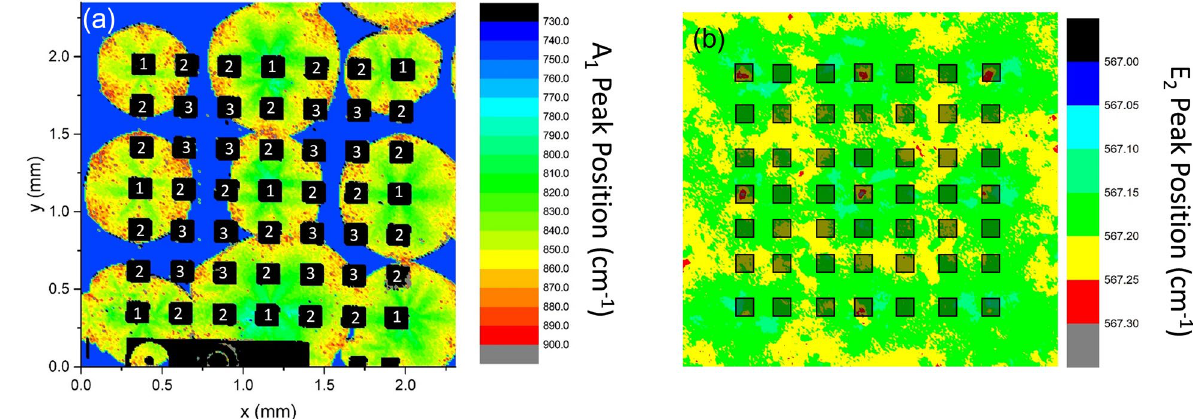
Figure 3. ( a ) Raman map of the A 1 (LO) peak on a 7 × 7 device reticle; the black areas are the regions are the metal contact to the anode. ( b ) Raman map of the E 2 peak of a similar region. Translucent black boxes are drawn where the diodes are expected to be fabricated. The devices are divided into 3 positons labeled in ( a ): Postion 1, on a point of high crystal stress; Position 2, adjacent to point of high crystal stress thus still on a point of higher carrier concentration; Position 3, on a higher resistivity point away from the crystal stress